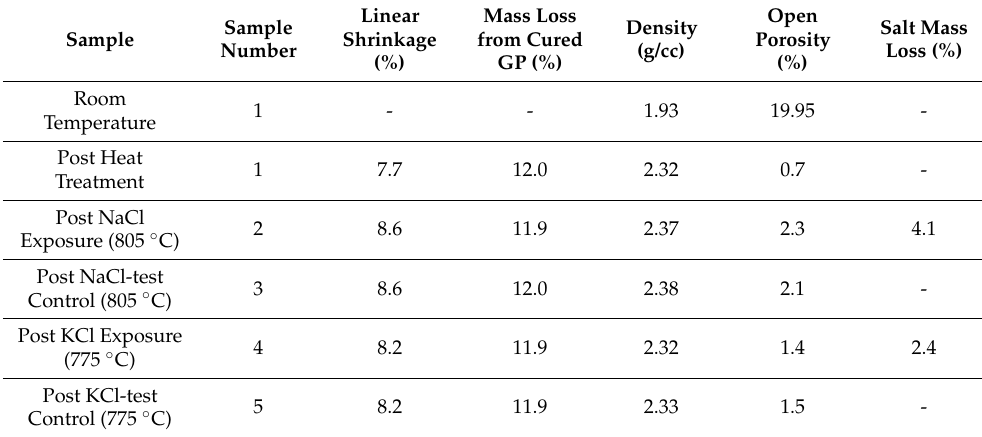
ized water as reference material. The results can be seen in Table 4. Table 4. Physical Changes Due to Prolonged Exposure to Molten G1 Chlorides. Table 4. Physical Changes Due to Prolonged Exposure to Molten G1 Chlorides.